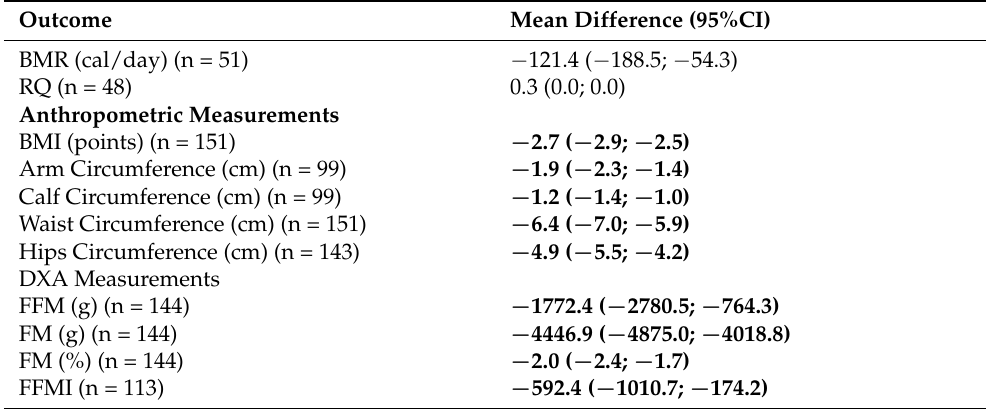
Table 2. ANCOVA analysis of the